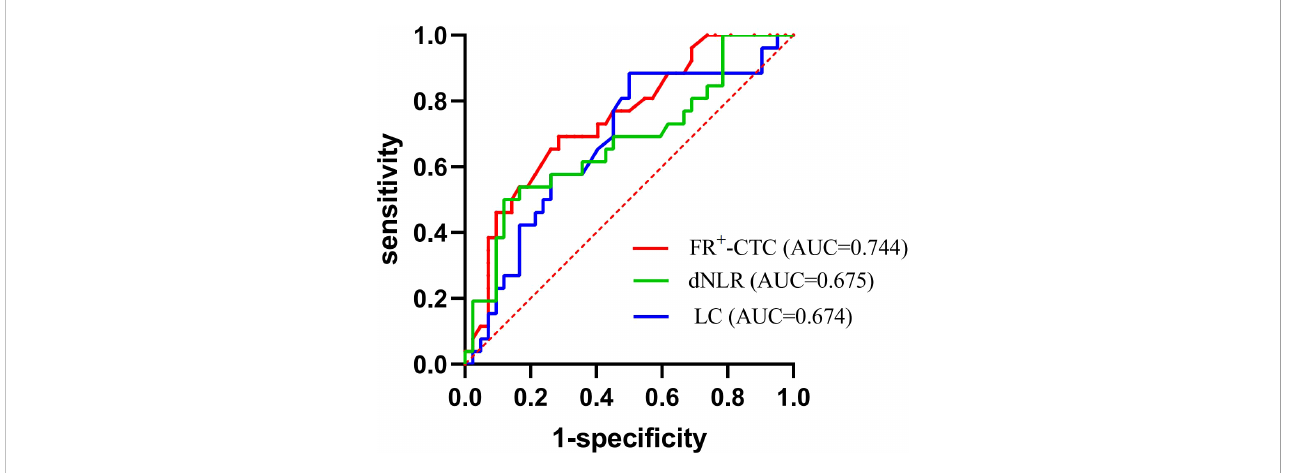
FIGURE 3 ROC curves of the FR + -CTC count, dNLR, and LC in the diagnosis of lung cancer